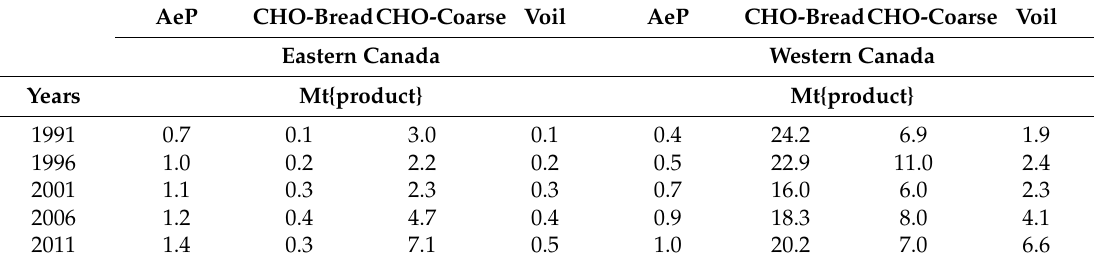
Table 6. The weight of Animal equivalent Protein (AeP), Carbohydrates (CHO): food quality (CHO-bread), feed or industrial use (CHO-coarse), and Vegetable oils (Voil), from Eastern and Western Canada over five census years. AeP CHO-BreadCHO-Coarse Voil AeP CHO-BreadCHO-Coarse Voil Eastern Canada Western Canada Years Mt{product}